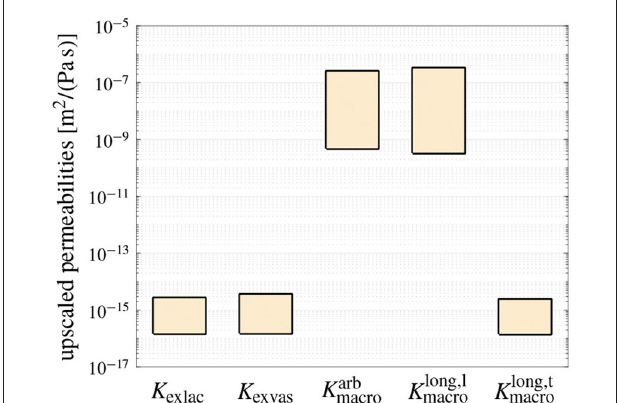
FIGURE 2 | The model-predicted, non-zero components of the isotropic permeability tensors of extralacunar bone matrix ( K exlac ), extravascular bone matrix ( K exvas ), and macroscopic bone tissue when considering arbitrarily oriented vascular pores ( K arb macro ), and of the transversally isotropic permeability tensor of macroscopic bone tissue when considering longitudinally oriented vascular pores ( K long,l macro and K long,t macro ), see Section 2.4 and the Supplementary Material for details; the ranges shown for each permeability highlight the resulting upper and lower limits when varying the canalicular, lacunar, and vascular porosities, and the corresponding pore radii within the physiologically reasonable ranges.